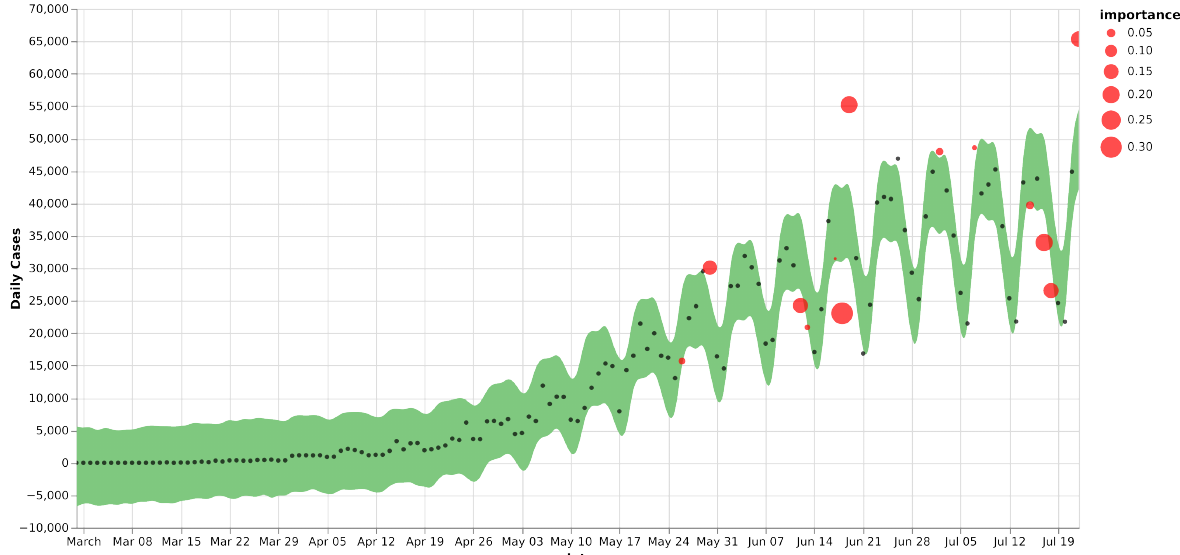
Figure 9. The confirmed cases reported in Brazil (black dots), line with an 80% confidence interval (green band), and the importance of outliers is annotated based on how far the dot is from the boundary of the confidence interval.